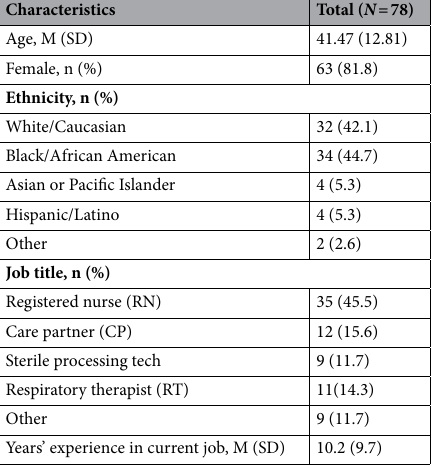
Table 1. Participant demographics.